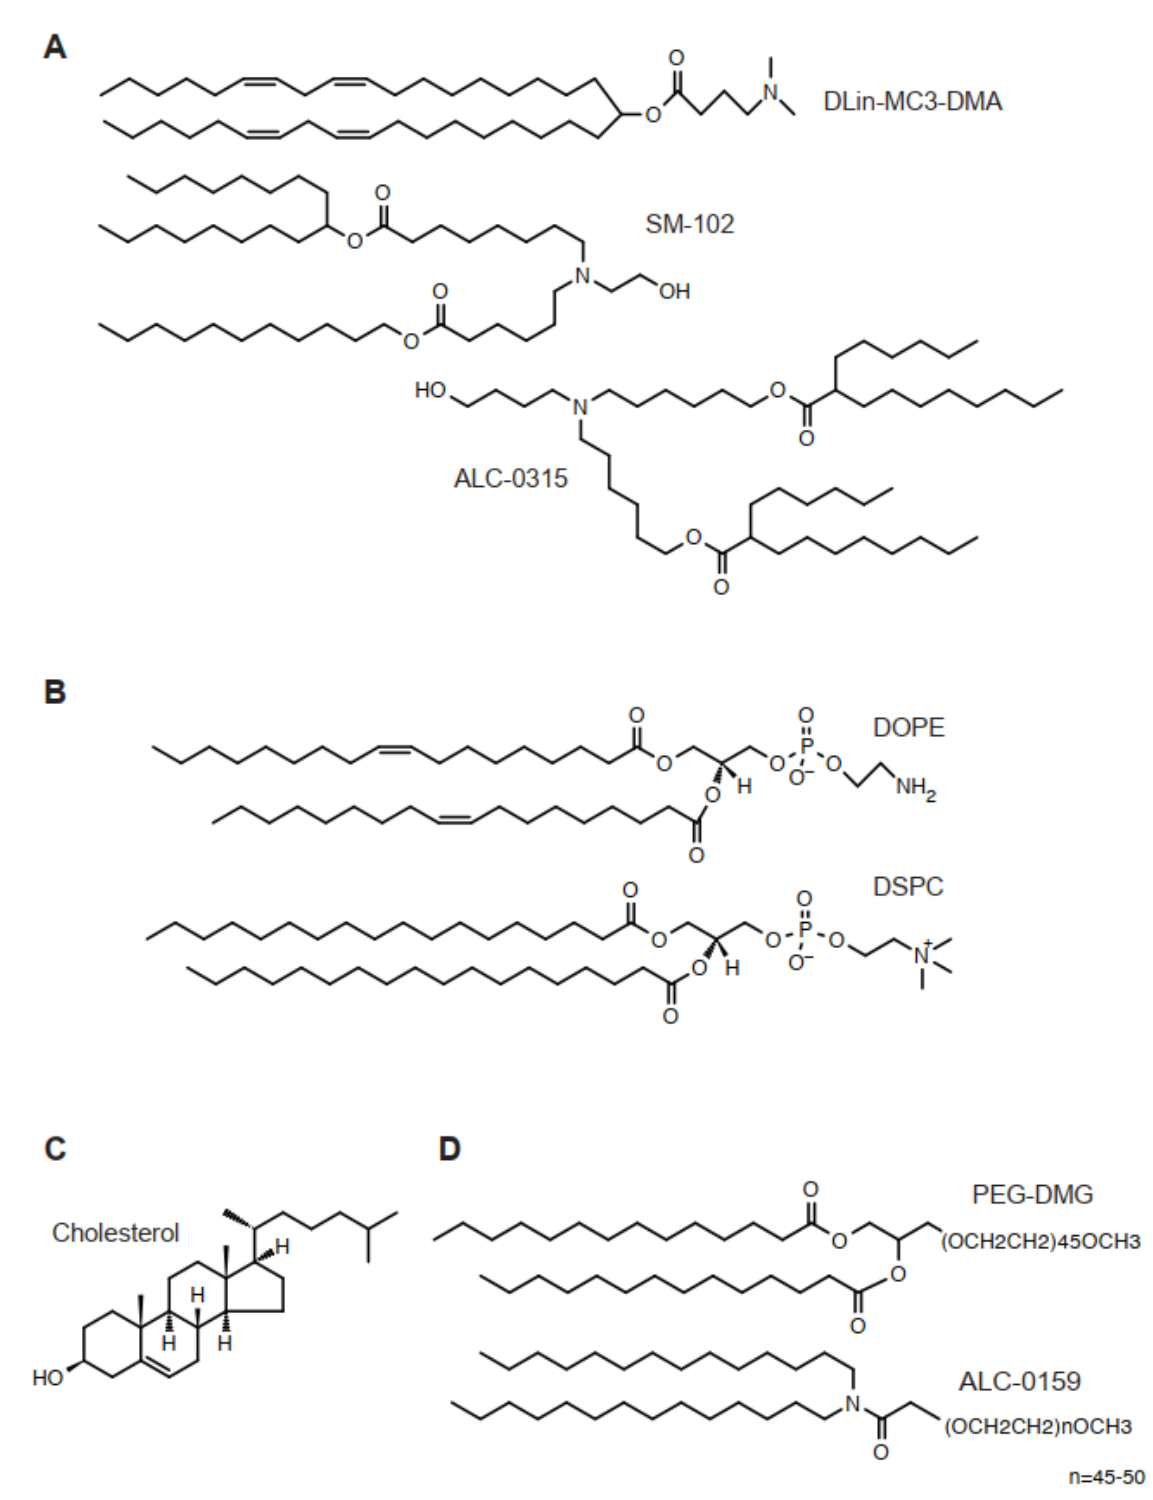
Figure 1. Chemical structure of lipids for LNP. ( A ) DLin-MC3-DMA, SM-102, and ALC-0315. ( B ) DOPE and DSPC. ( C ) Cholesterol. ( D ) PEG-DMG and ALC-0159. ( B ) DOPE and DSPC. ( C ) Cholesterol. ( D ) PEG-DMG and